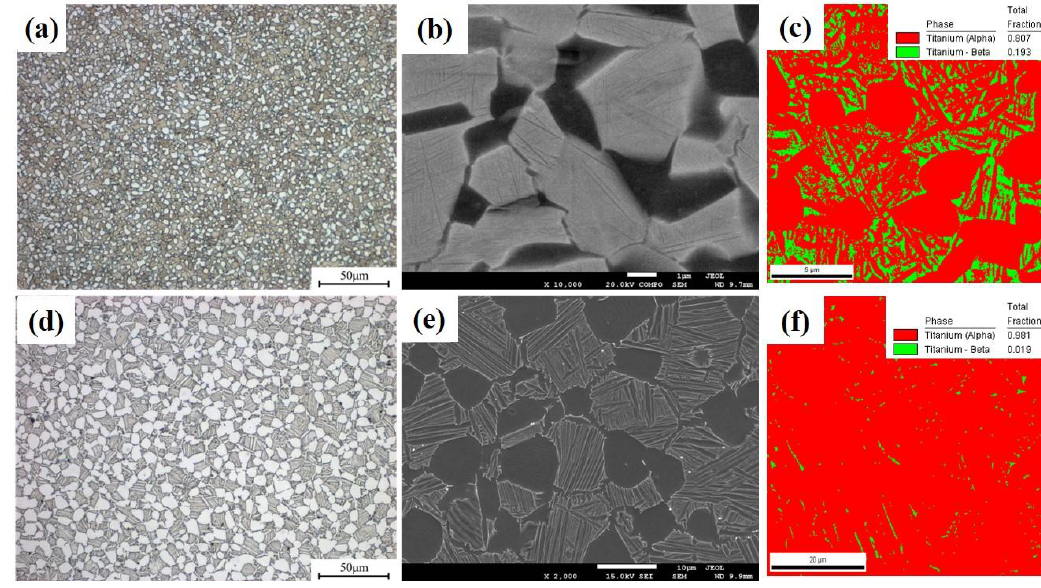
Figure 2. Microstructures of the investigated alloys after heat treatment: ( a – c ) HBA; ( d – f ) LBA. Table 2. Microstructural parameters of the investigated alloys after heat treatment. Samples